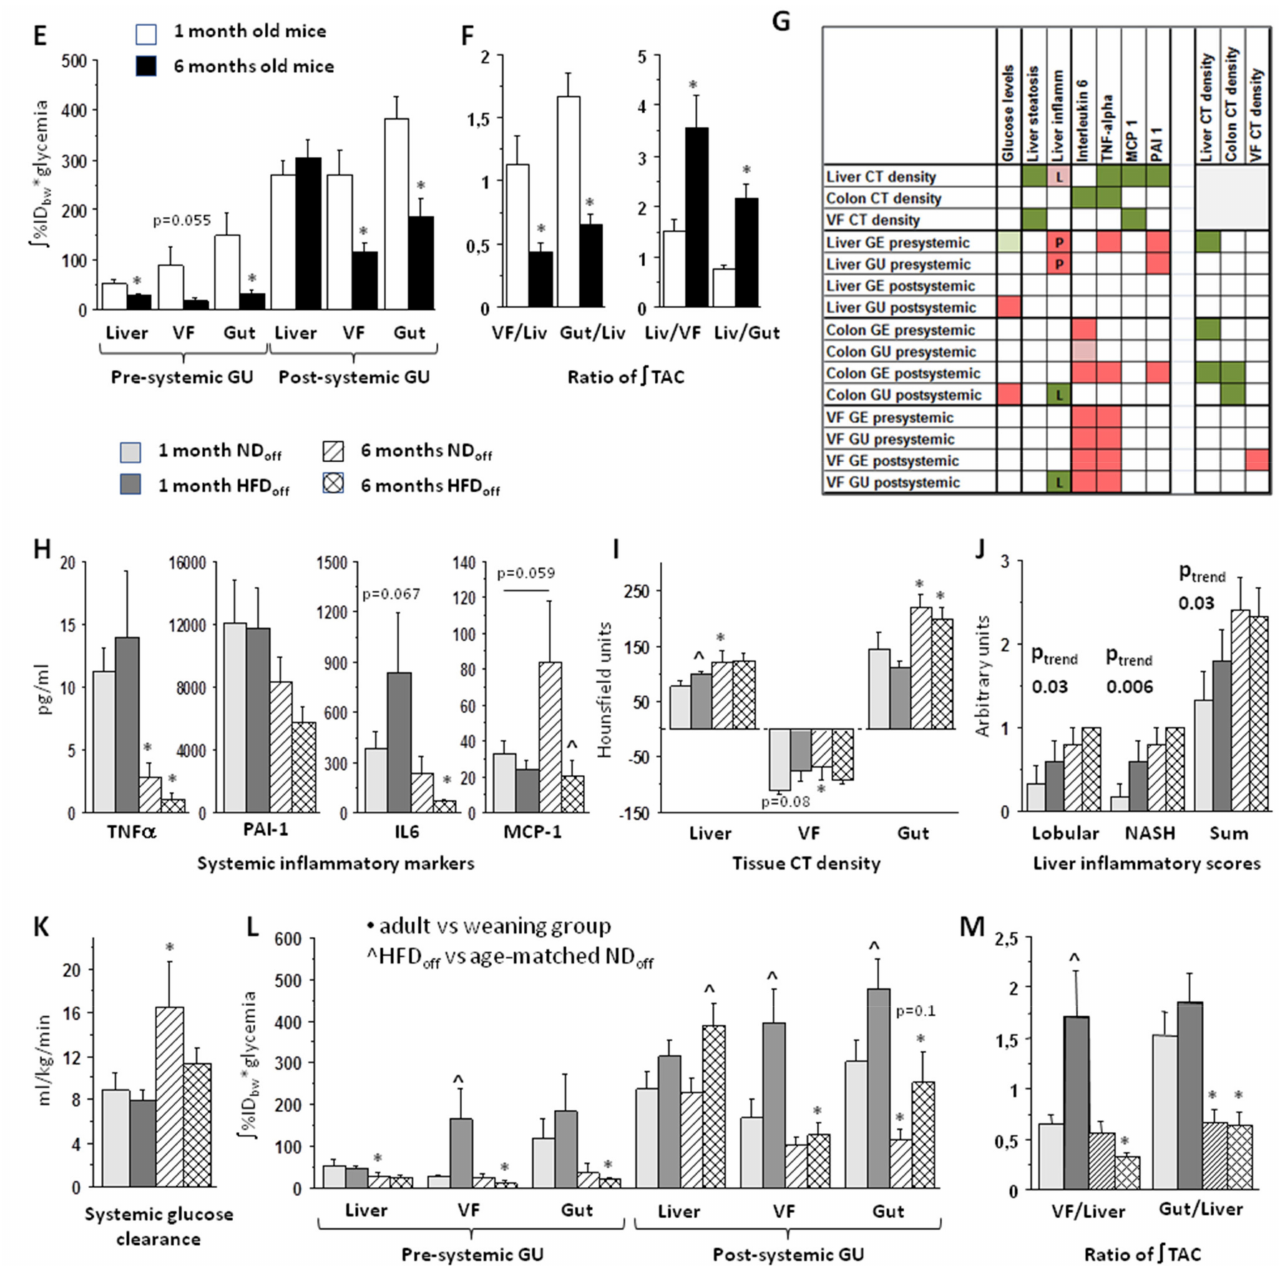
Figure 1. Top panels illustrate the findings according to age-stratified offspring groups (weaning vs. adult mice), showing profound differences in inflammatory markers ( A ), tissue structure by CT ( B ), or liver histology ( C ), systemic glucose metabolism ( D ), glucose uptake rates by PET in liver, visceral fat, gut ( E ), and their ratios ( F ). Panel G documents associations (L = lobular, P = portal inflammation). Corresponding variables are shown in bottom panels ( H – M ) in the offspring stratified according to maternal diet*age. GE = glucose extraction, GU = glucose uptake, VF = visceral fat, TAC = time-activity curve, EGP = endogenous glucose production, NASH = non-alcoholic steatohepatitis, CT density refers to attenuation coefficients, i.e., radiodensity in Hounsfield units; * p < 0.05 adult vs. weaning group, ˆ p < 0.05 age-matched HFDoff vs. NDoff; relevant borderline differences are also shown (as text); in ( G ), red (positive), green (negative) associations, dark colors p < 0.05, light colors p ≤